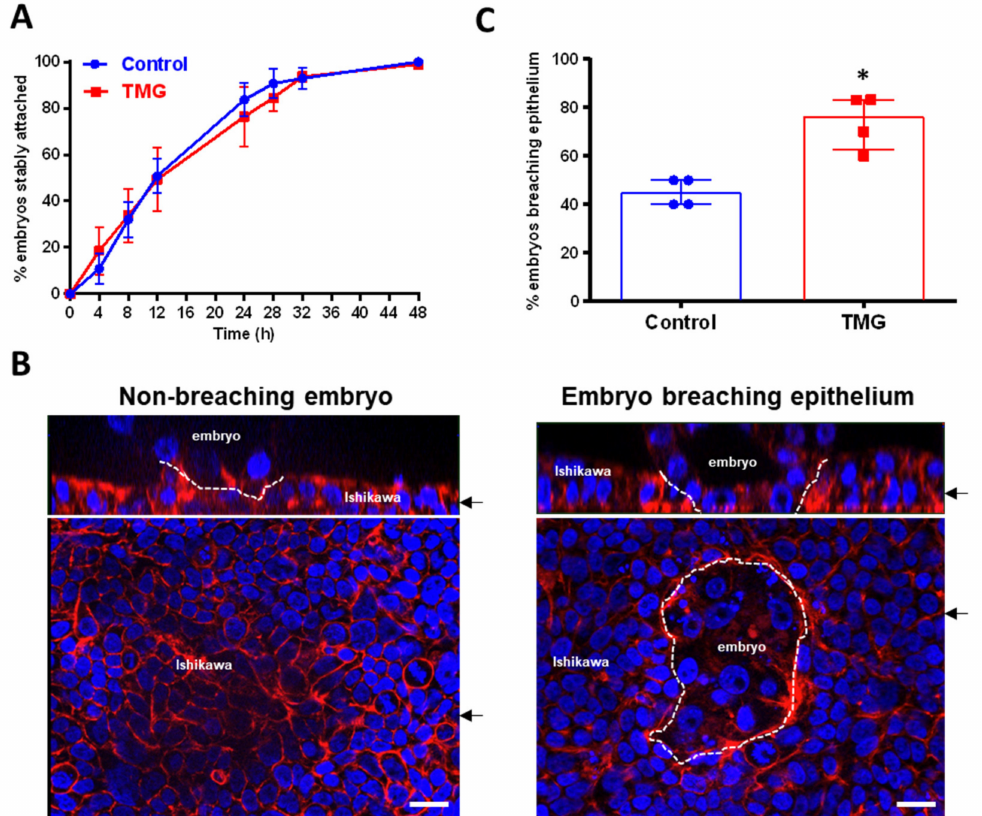
Figure 2. E5.5 blastocysts, previously untreated (control) or treated with 5 µ M TMG were co-cultured with Ishikawa cell layers for 48h. ( A ) The percentage of stably attached embryos was monitored throughout co-culture ( n = 4; 12–16 embryos per experiment; mean ± SEM). ( B ) Co-cultures were fixed after 48 h and stained with phalloidin to label actin (red) and DAPI to label nuclei (blue). Fluorescence microscopy with optical sectioning allowed for the determination of embryonic breaching of the Ishikawa cell layer. Dotted lines indicate embryo–Ishikawa interface. Single optical sections are shown in lower panels and Z-stacks of optical sections in upper panels. Arrows indicate position of optical section and Z-stack. Embryos and Ishikawa cell are labelled. Scale bars 20 µ m. ( C ) Percentage embryos that have breached the Ishikawa cell layer ( n = 4; 12–16 embryos per experiment; median ± IQR; * p < 0.05; Mann–Whitney